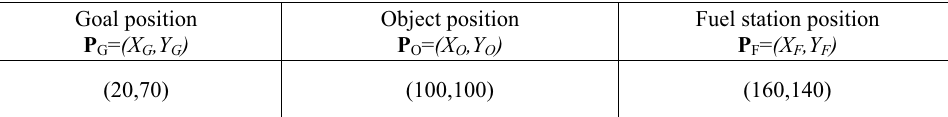
Table 8. Initial position of the moving object and positions of goal and fuel station. Goal